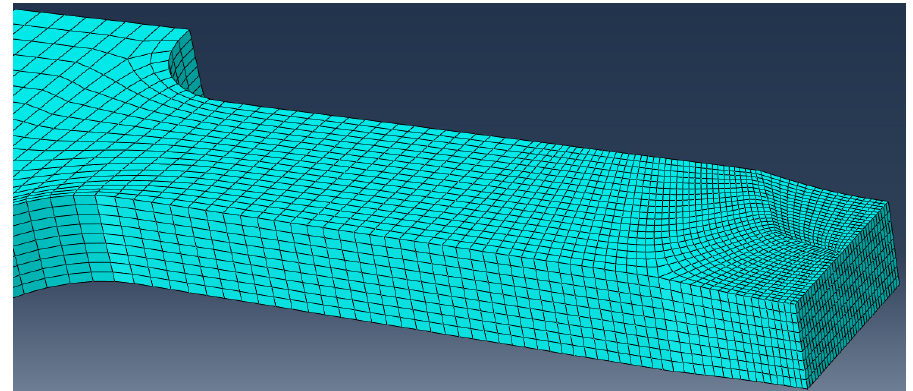
Figure 3. FE model of specimen P1-1 with deformed weld metal.